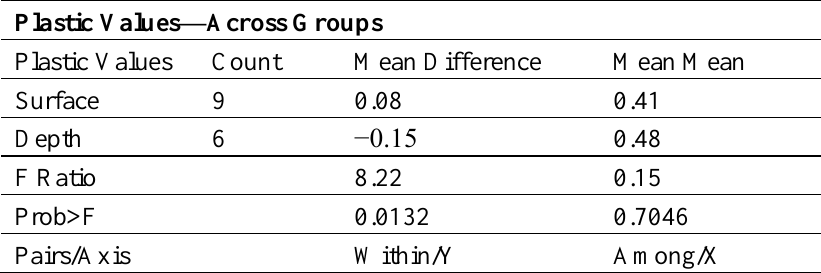
Table 4. (Alt.) Matched Pairs Comparison on Copy Exercise: Reproductions in Original versus Altered Drawings grouped by Plastic Values (Ambiguous Excluded).